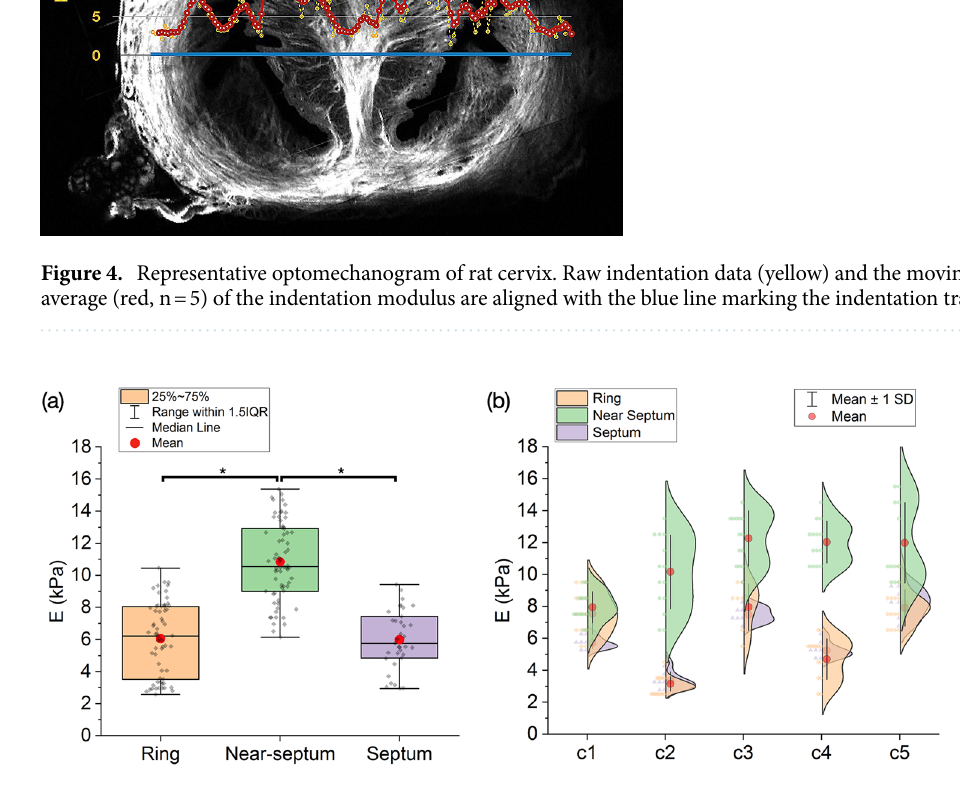
right in Fig. 4, reveals the variation of the indentation modulus across the cervix, covering the three regions. The co-registration method aligns the coordinate systems of the indenter and the SHG microscope in order to obtain